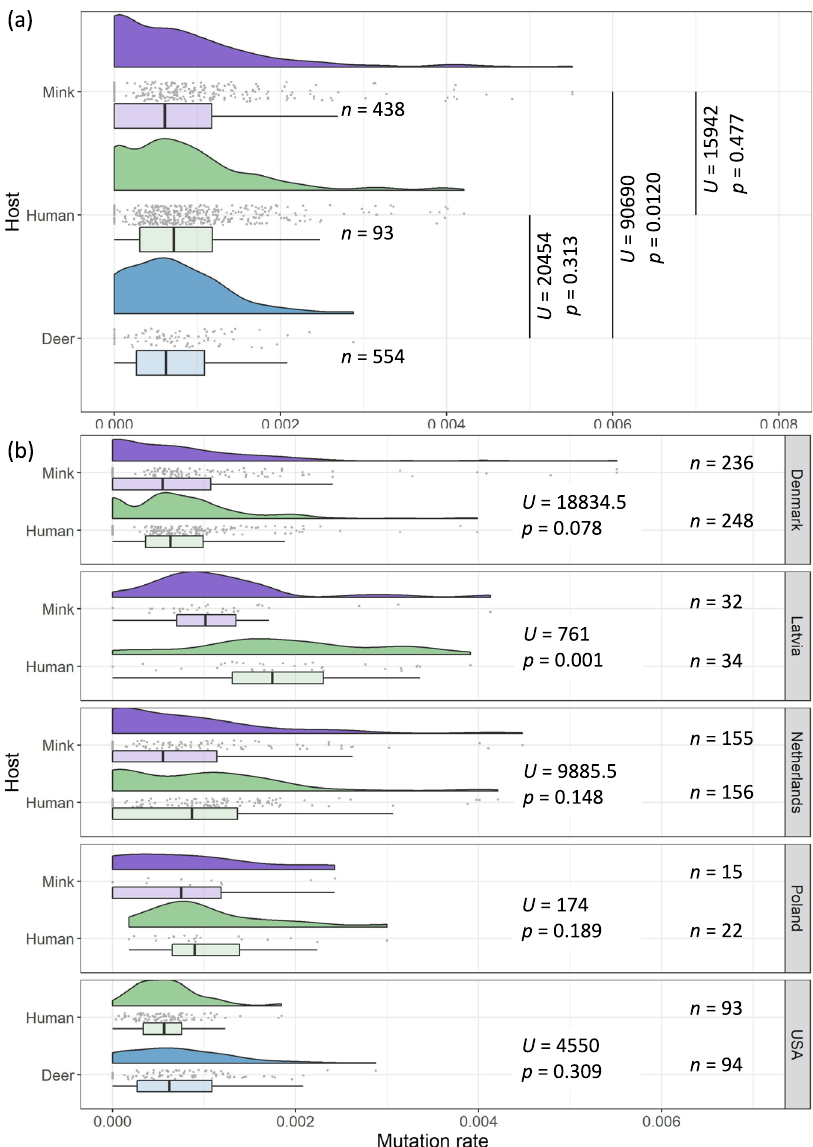
Fig. 5 Host-speci fi c substitution rate variation. Raincloud plots 95 of terminal branch lengths strati fi ed by a host, and b by both host and country. These plots comprise Gaussian kernel probability density, scatter and box-and-whisker plots (centre line, median; box limits, upper and lower quartiles; whiskers, 1.5x interquartile range). Multiple mink-human maximum-likelihood phylogenies of mink and human background 1 isolates were reconstructed and used for tip-calibration. Isolates that did not have complete dates or that were duplicate sequences were removed prior to analysis. The fi nal number of isolates in each stratum that were used for tip-calibration, Mann – Whitney U -statistics and their associated p -values (based on a two-sided test), are